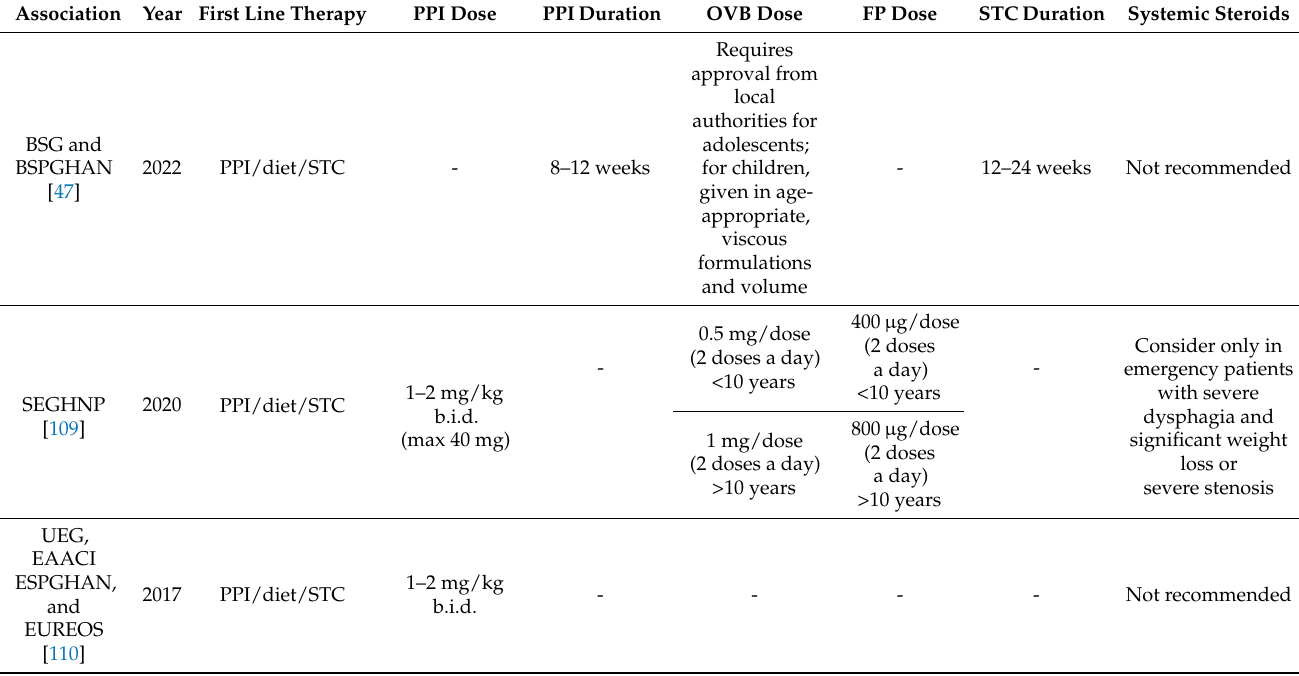
Table 3. Comparison of EoE treatment guidelines for